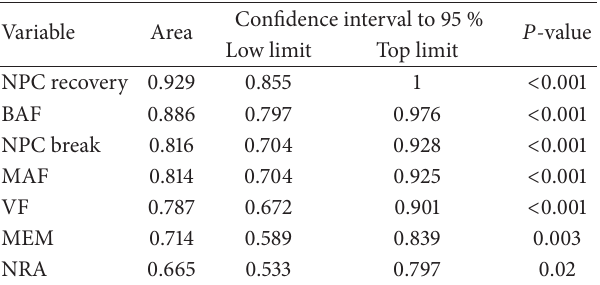
Table 3: Area under the ROC curve for different